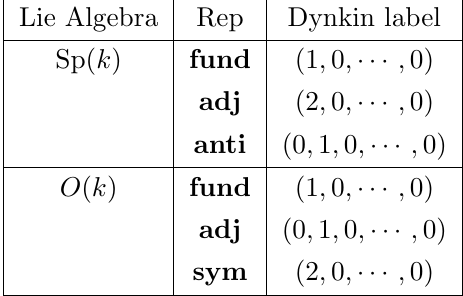
Table 2 . The Dynkin labels of